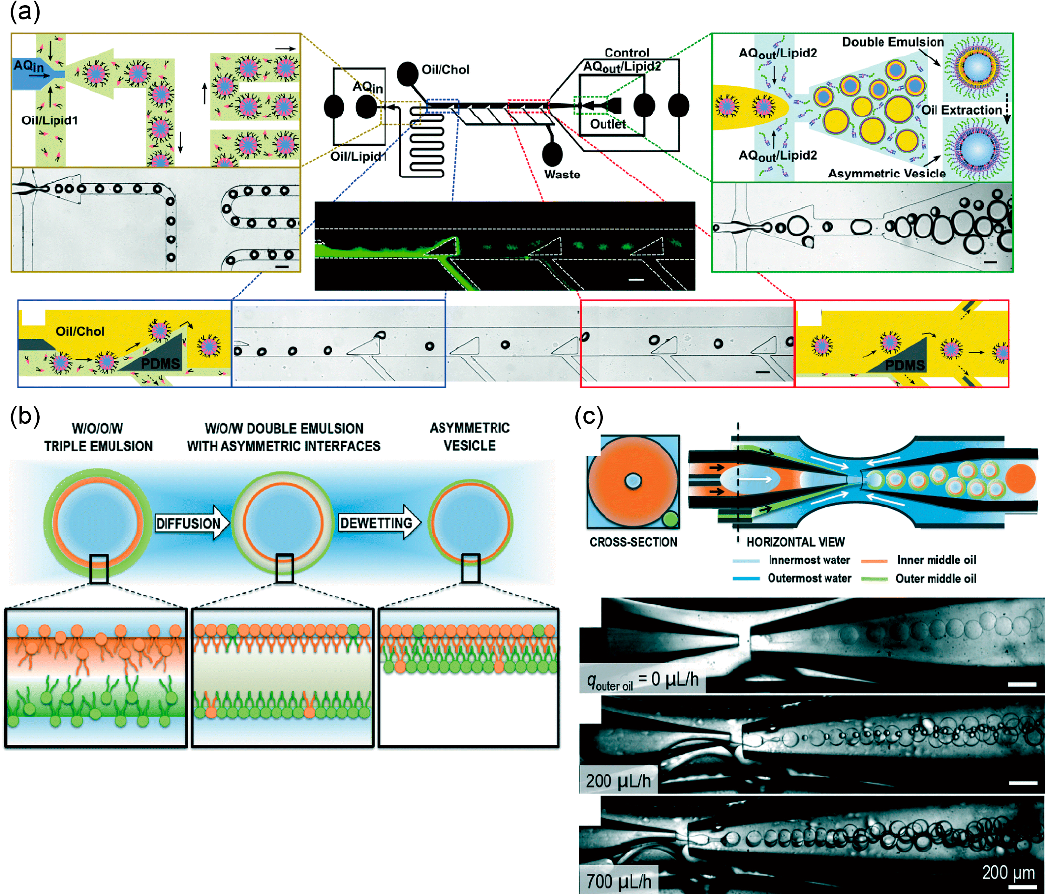
Figure 3. ( a ) Microfluidic device for generating asymmetric water-in-oil-in-water double emulsions with 50–150 μ m diameter. Asymmetric lipid vesicles are generated from the asymmetric double emulsions by extracting an intermediate oil layer. Reproduced with permission from [98]. ( b ) Schematic illustration of a formation method of asymmetric lipid vesicles generated from water-in-oil-in-oil-in-water triple emulsions; ( c ) illustration and optical microscope images of microfluidic devices to form the triple emulsions. (( b , c ) are reproduced with permission from [99].). Table 1. Summary of the giant lipid vesicle formations.